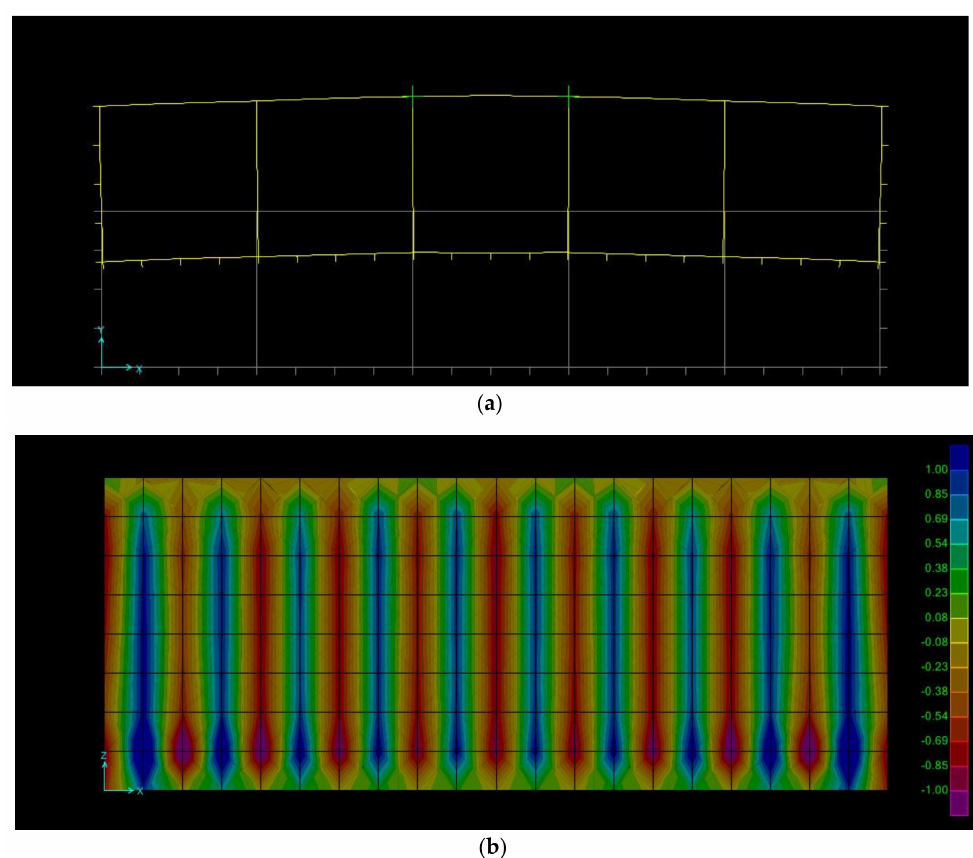
Figure 24. Results of the Simulation of PA and PE profiles: ( a ) View plan of the deformation of the upper profile; ( b ) Variation of bending moments in the long wall